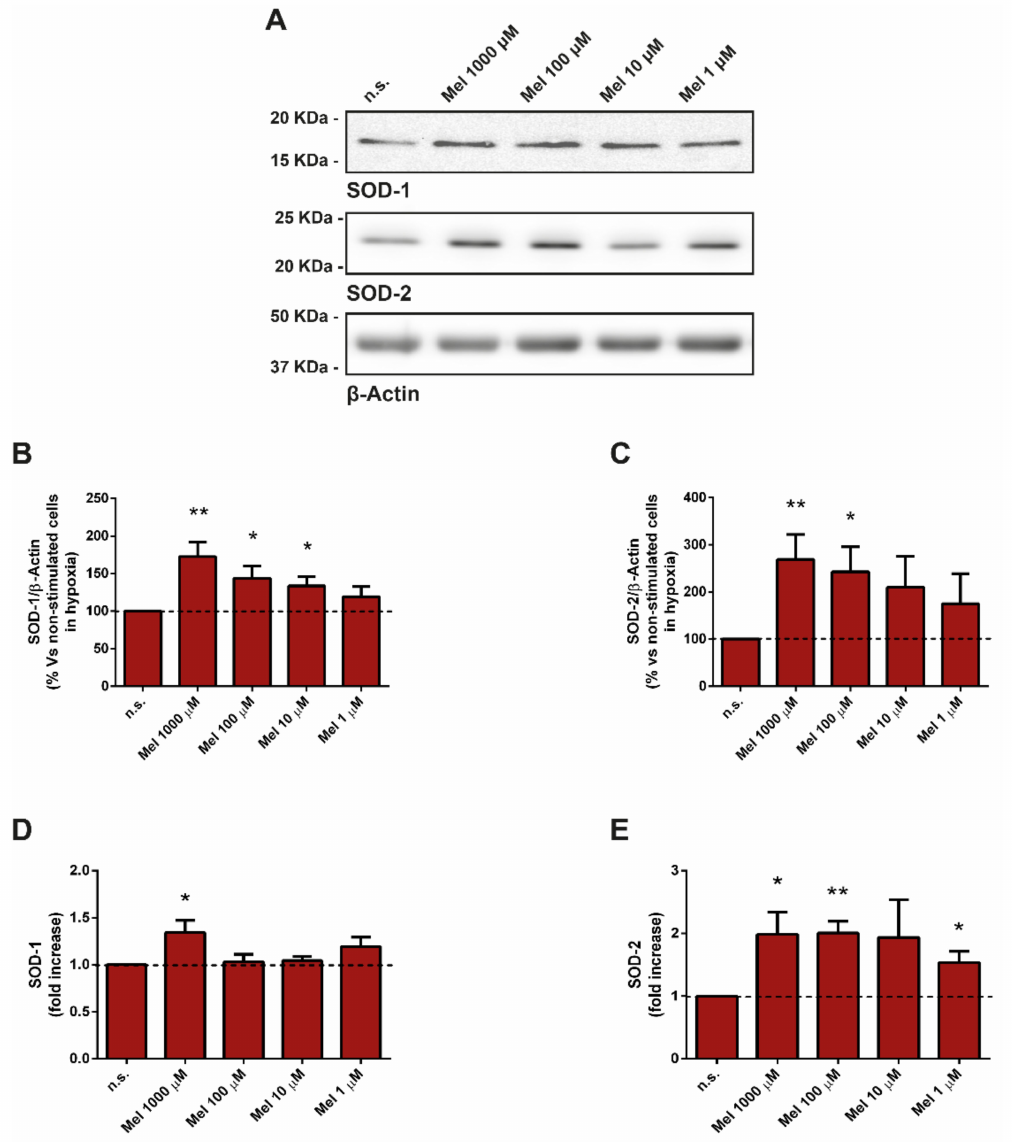
Figure 3. Effect of melatonin on superoxide dismutase (SOD). PSCs were incubated with melatonin (1000 µ M, 100 µ M, 10 µ M, or 1 µ M) during 4 h under hypoxia. ( A ) Determination of the expression of SOD1 and SOD2 was carried out by Western blotting, employing specific antibodies. The blots show the effect of melatonin on the expression of these proteins. The levels of β -actin were used as controls to ensure equal loading of proteins. ( B , C ) The graphs show the quantification of protein expression. A horizontal dashed line represents the value observed in cells incubated in the absence of melatonin (non-treated). Values are the mean ± S.E.M. of normalized values expressed as % with respect to non-treated cells (incubated under hypoxia and in the absence of melatonin). ( D , E ) Detection of mRNA levels of SOD1 and SOD2 was carried out by RT-qPCR analysis. The bars show the fold increase of mRNA levels ± S.E.M. of each protein relative to non-treated cells (incubated under hypoxia and in the absence of melatonin). Gapdh mRNA was used for normalization. A horizontal dashed line represents the value observed in non-treated cells. Results are representative of three to four independent experiments (n.s., non-treated; Mel, melatonin; *, p < 0.05; and **, p < 0.01 vs. non-treated cells in